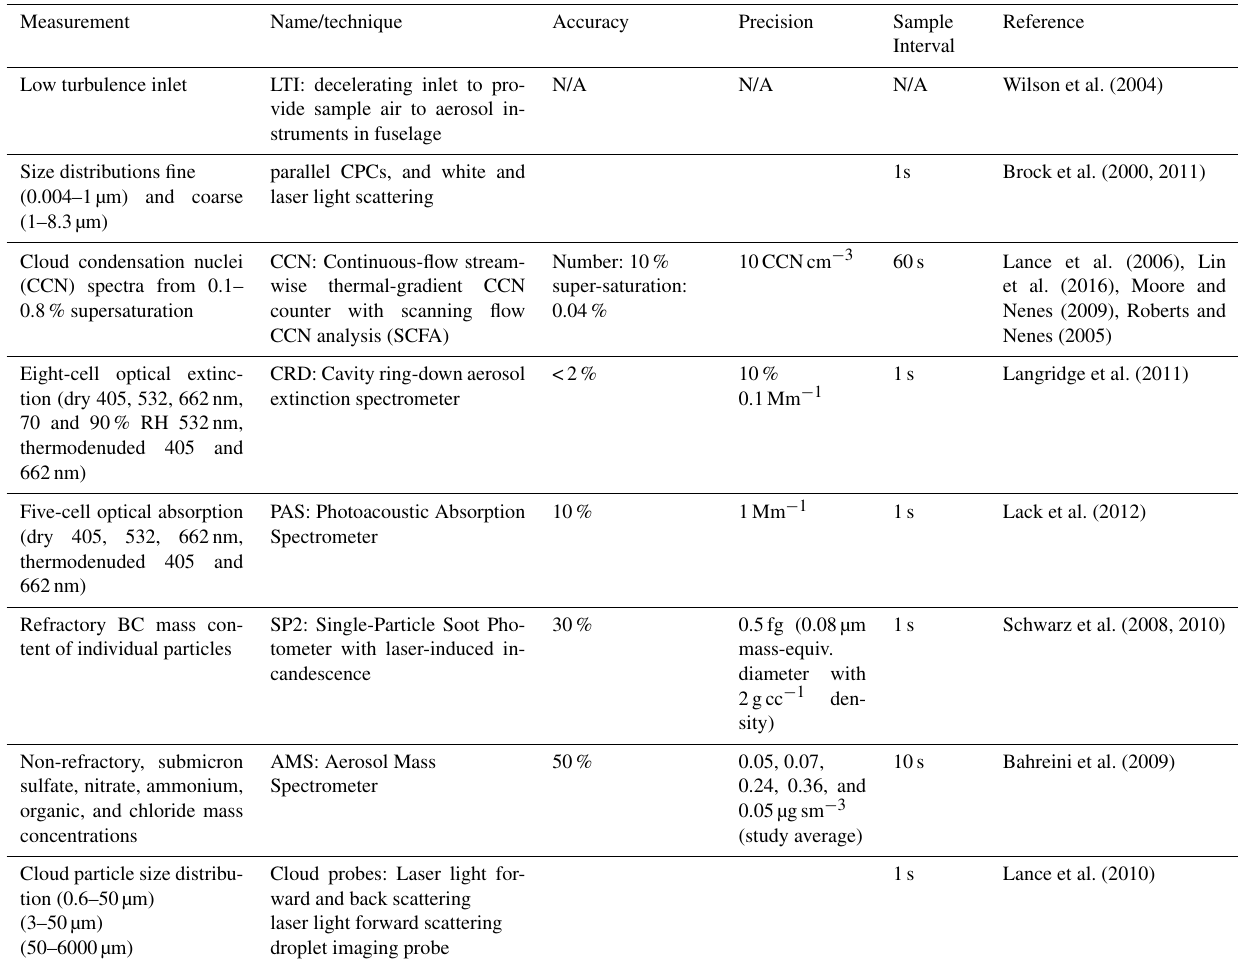
Table 5. Aerosol instrumentation on the NOAA WP-3D during SENEX.